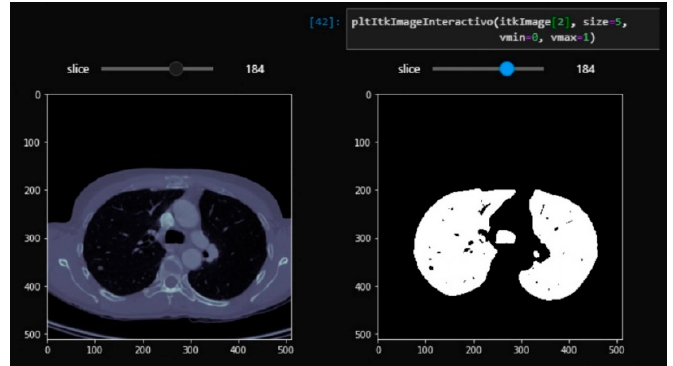
Figure 2. Digital imaging and communication on medicine (dicom) images of the Lung Image Database Consortium and Image Database Resource Initiative (LIDC-IDRI) dataset with the volume superimposed. Visualization used to check segmentation results during implementation. ( A ) Image 20; ( B ) Image 90; ( C ) Image slice 170; ( D ) Image slice 235;